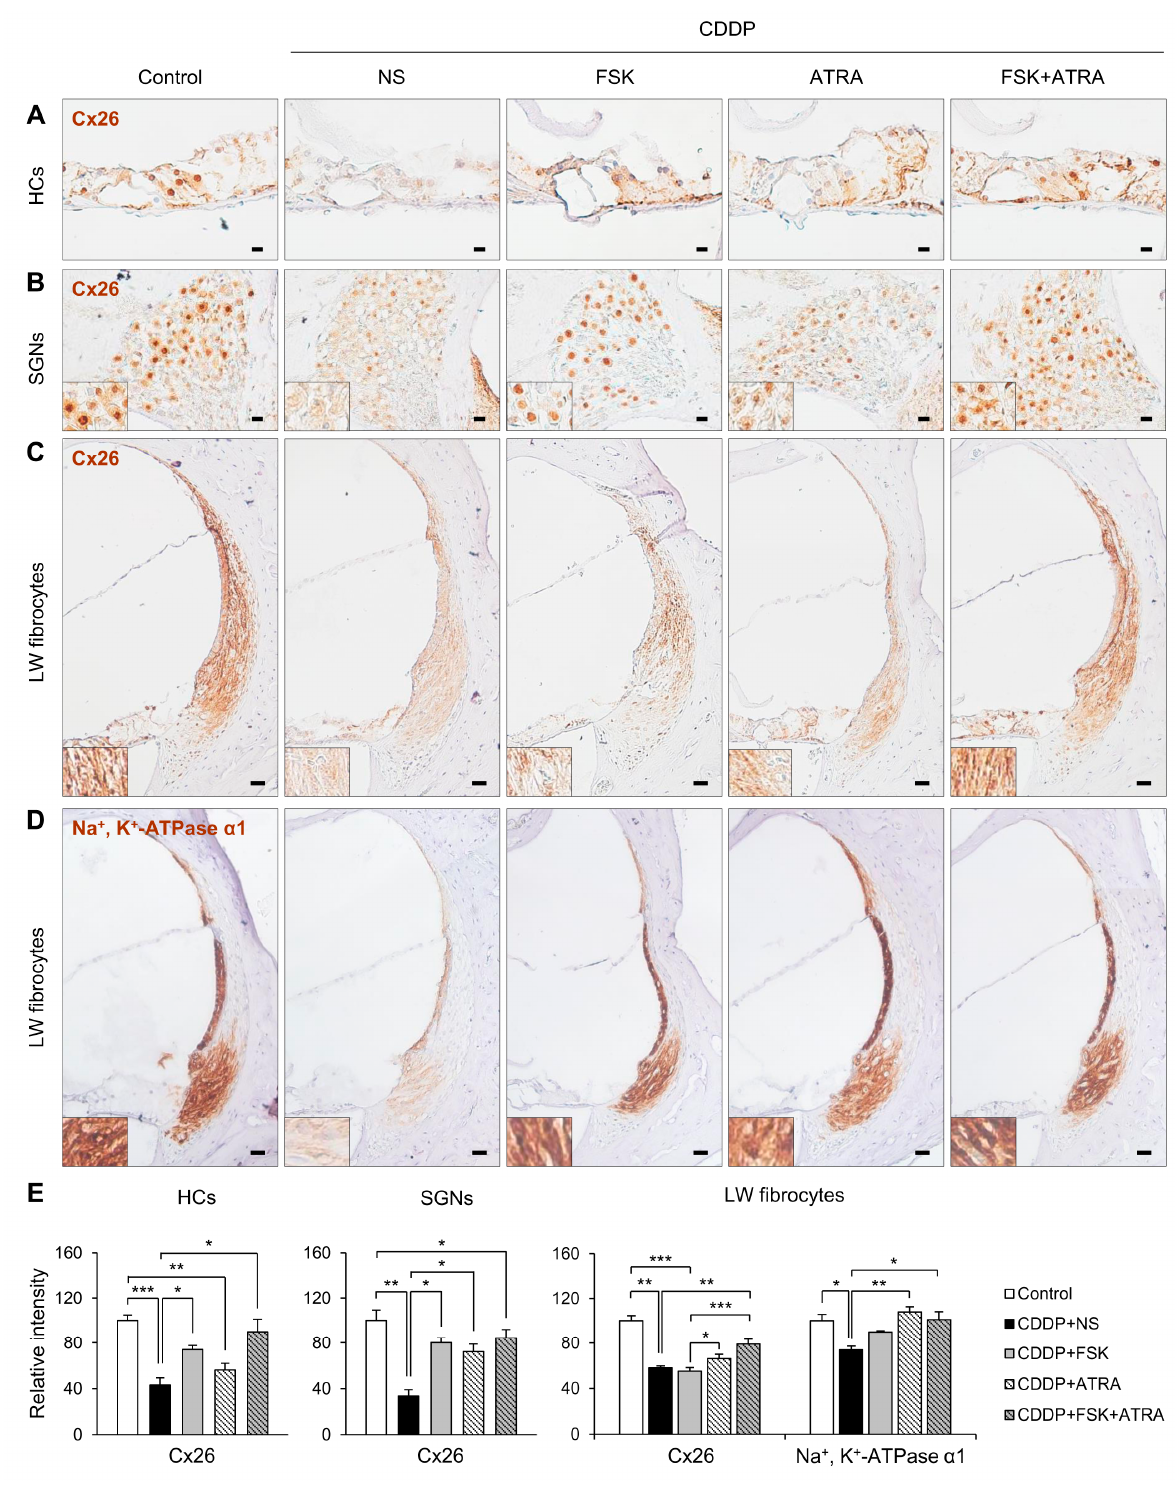
Figure 5. Immunohistochemical staining of Cx26 and Na + /K + -ATPase in rats treated with NS, FSK, ATRA, or FSK + ATRA under CDDP exposure. Representative images of Cx26 (brown, DAB) in the OC ( A ), SGNs ( B ), and LW fibrocytes ( C ) obtained from the middle turn of the cochlea (n = 5 per group). ( D ) Representative image of Na + /K + -ATPase in LW fibrocytes. The cells were counterstained with hematoxylin (blue). The inset shows a magnified image of the square box. ( E ) Quantification of the chromogenic intensity in the OC, SGNs, and LW fibrocytes in the middle turn of the cochlea in each group. Scale bar = 20 µ M * p < 0.05, ** p < 0.01, *** p < 0.001. NS, normal saline; CDDP, cisplatin; FSK, forskolin; ATRA, all-trans retinoic acid; OC, organ of Corti; SGNs, spiral ganglion neurons; LW, lateral wall; Cx26,